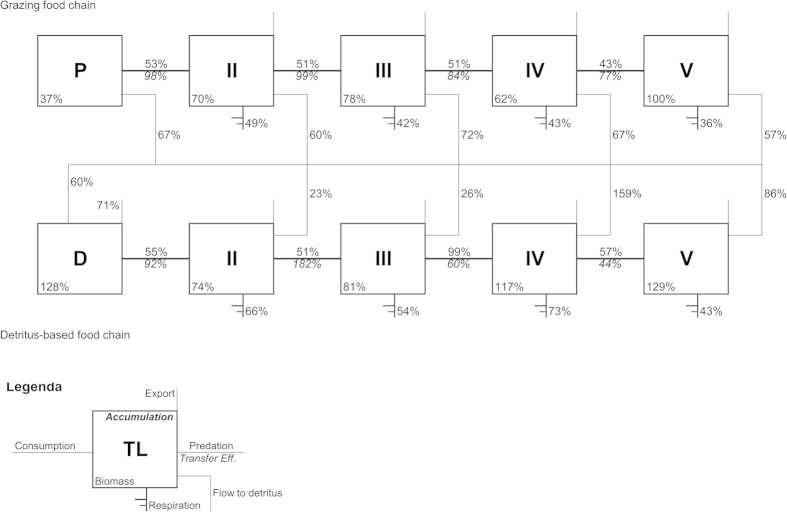
Lindeman spine.Grazing food chain (upper part) and detritus-based food chain (lower chain). Ratio between values referred to blue and green states are shown as percent.